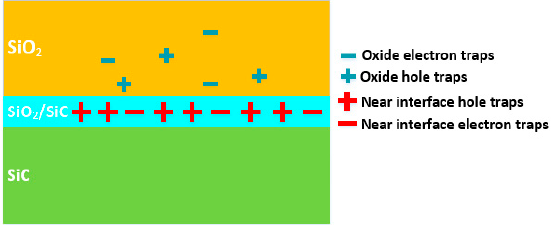
Figure 12. The shift of V FB of the samples versus proton fluence extracted from the HF C-V characteristics.